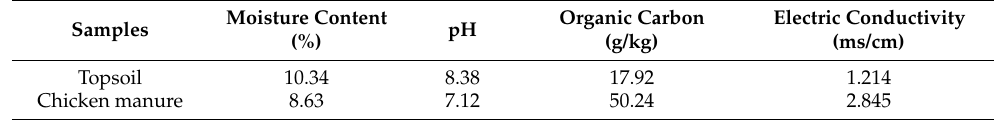
Table 1. Physical and chemical properties of topsoil and chicken